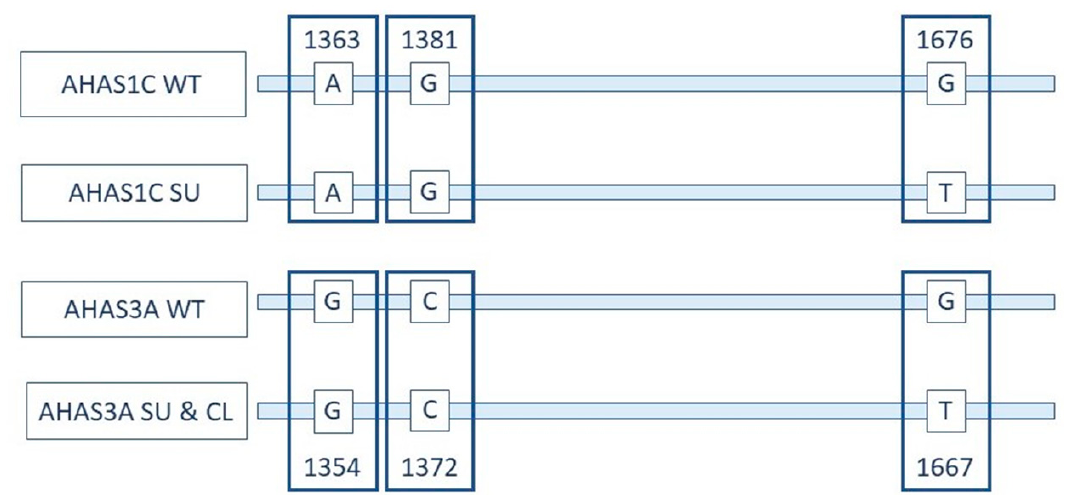
Figure 1. Relationship between AHAS1C and AHAS3A and positions of a key mutation. Representation of coding strands of the AHAS1C gene and AHAS3A gene in wild-type (WT), genome edited for sulfonylurea and imidazolinone tolerance (SU) and Clearfield (CL) canola varieties. These regions of the AHAS1C and AHAS3A genes are identical except for the bases indicated. Di ff erences in numbering of the two genes is due to di ff erences in sequences upstream of the region depicted. The two SNVs at 1363 / 1354 and at 1381 / 1372 di ff erentiate AHAS1C from AHAS3A . The SNV at 1676 / 1667 di ff erentiates AHAS1C SU , AHAS3A SU and AHAS3A CL from AHAS1C WT and AHAS3A WT . See papers cited in this section for details on structure of the AHAS gene